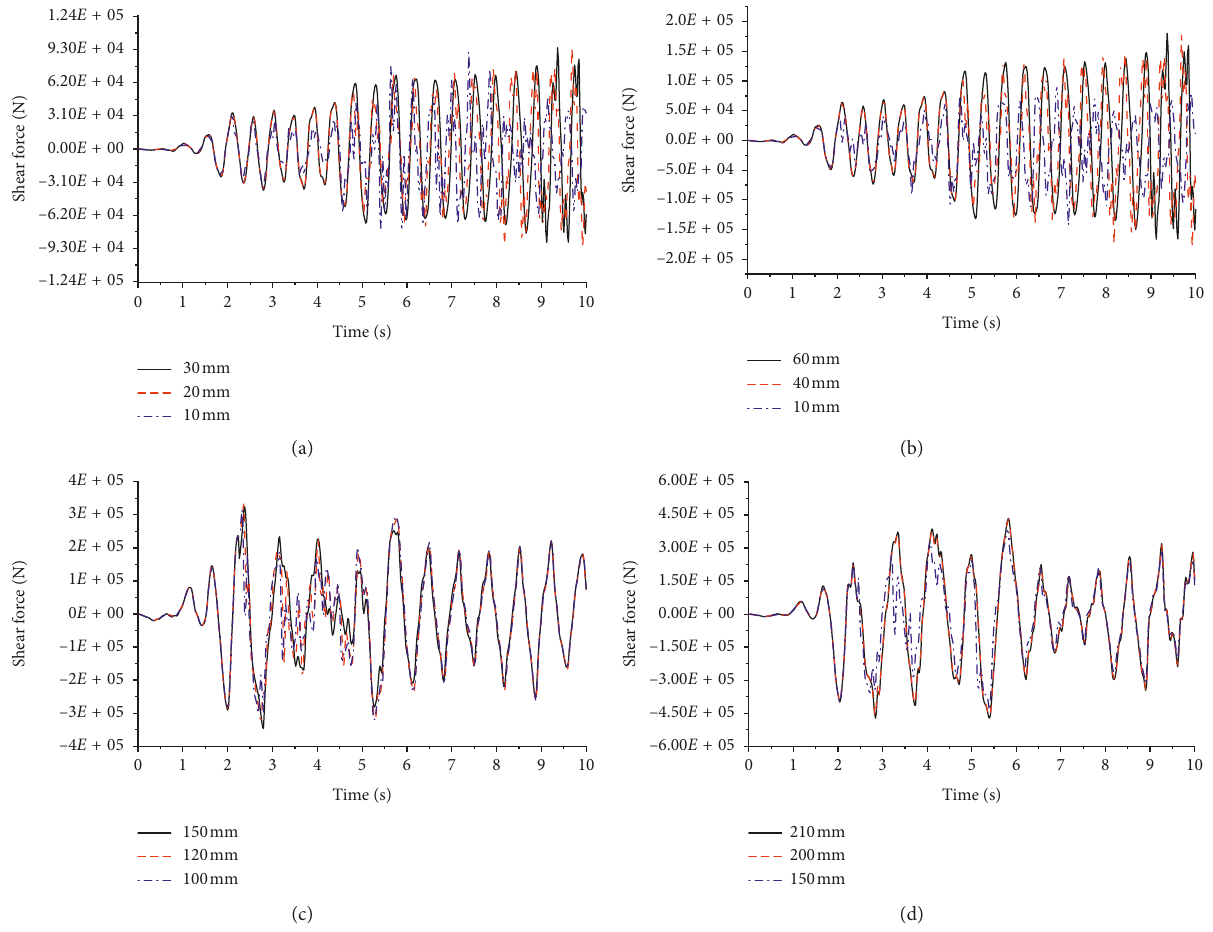
2 , (b) 70cm/s 2 , (c) 220cm/s 2 , and (d) 400cm/s 2 1 -A 11 . (a) 35 cm/s